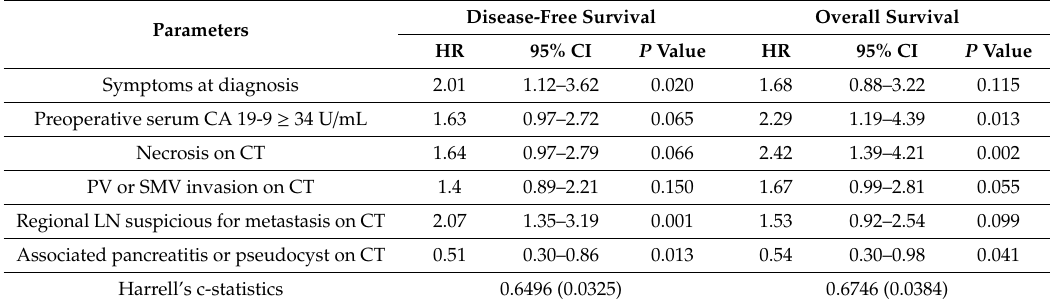
Table 2. Preoperative parameters to predict disease-free survival and overall survival of patients with resectable pancreatic